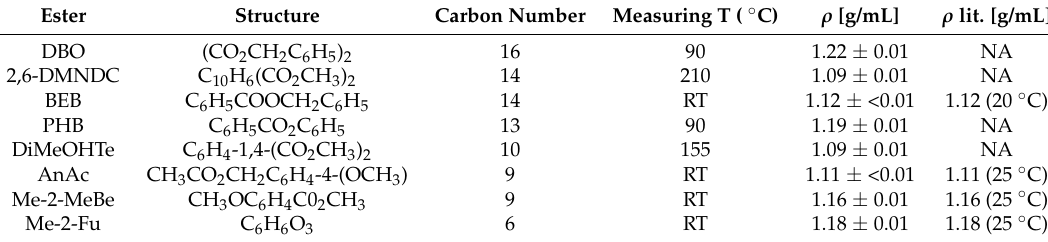
Table 1. Summary of the densities ρ (g/mL) measured for the aromatic esters presented. As the measurements were conducted with the materials in the liquid state, the measurement temperatures vary from sample to sample. For each ester, the chemical structure and carbon numbers are indicated alongside the temperature ( ◦ C) at which the measurements were performed. In this case, RT stands for “Room Temperature”, which amounts to approximately 25 ◦ C. If present, density values from the literature (lit.) (Sigma Aldrich) are reported alongside the measuring temperature. The missing values are indicated as Not Available (NA). All the ρ of the aromatic esters are higher than 1, which gives rise to higher volumetric ∆ H